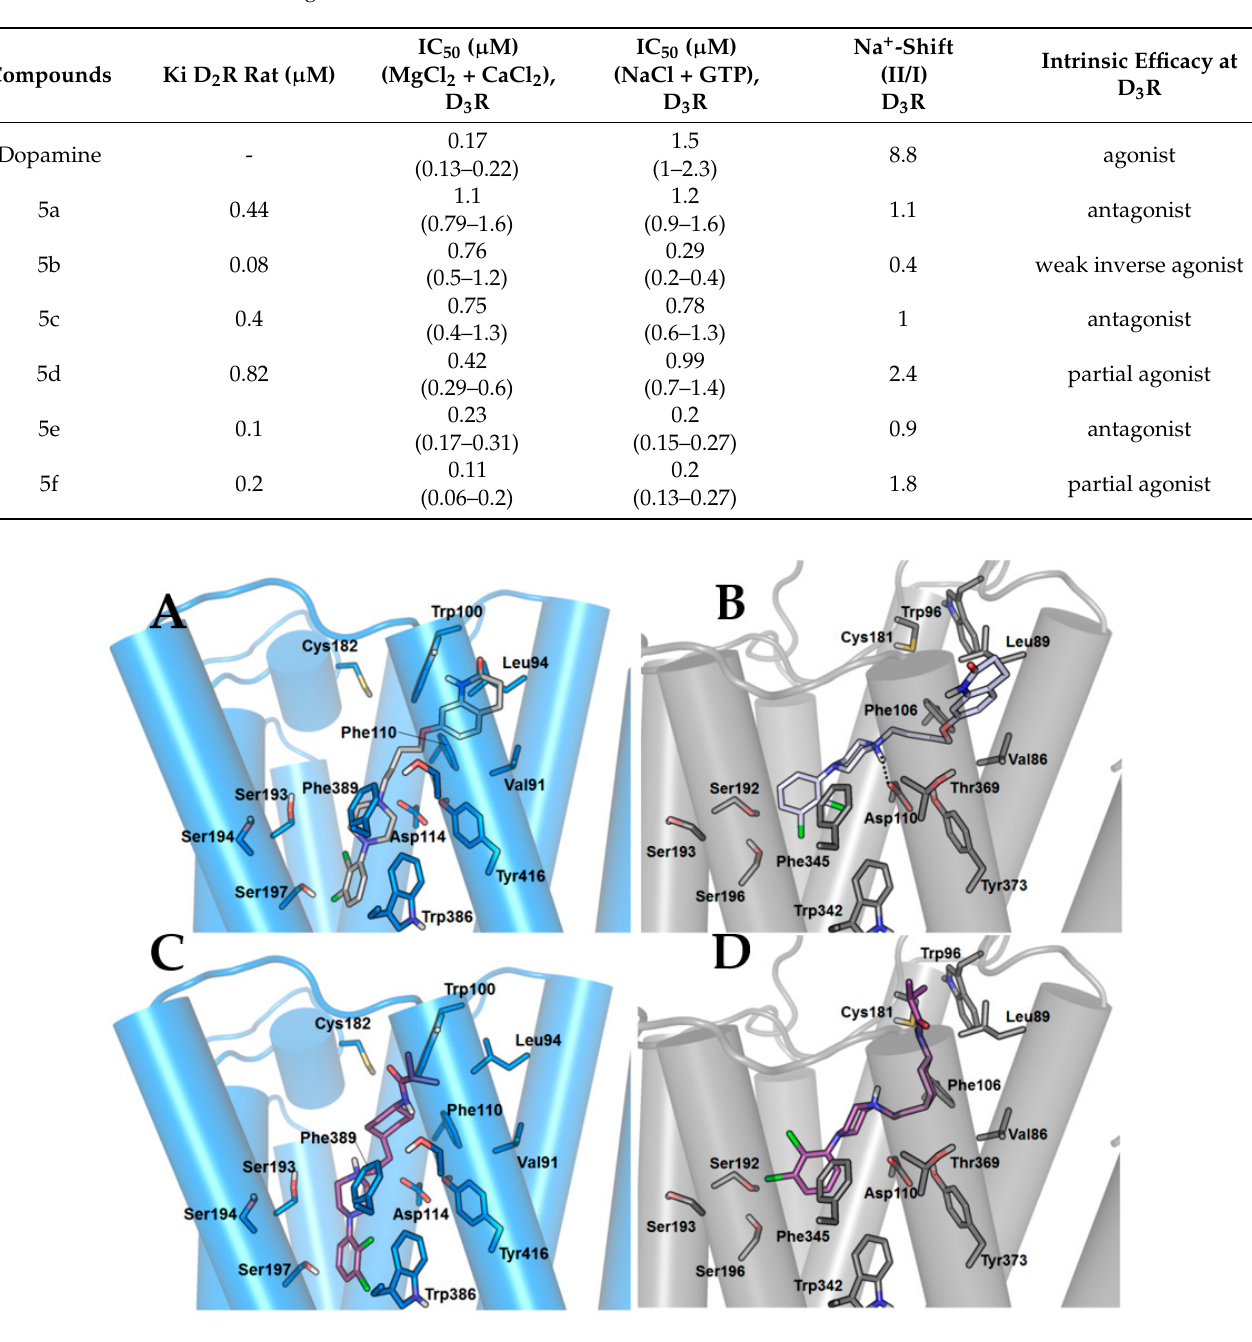
Figure 2. Interaction profile of prototype compounds on D 3 (gray) and D 2 (blue) receptors. ( A , B ): aripiprazole (gray); ( C , D ): cariprazine (purple).